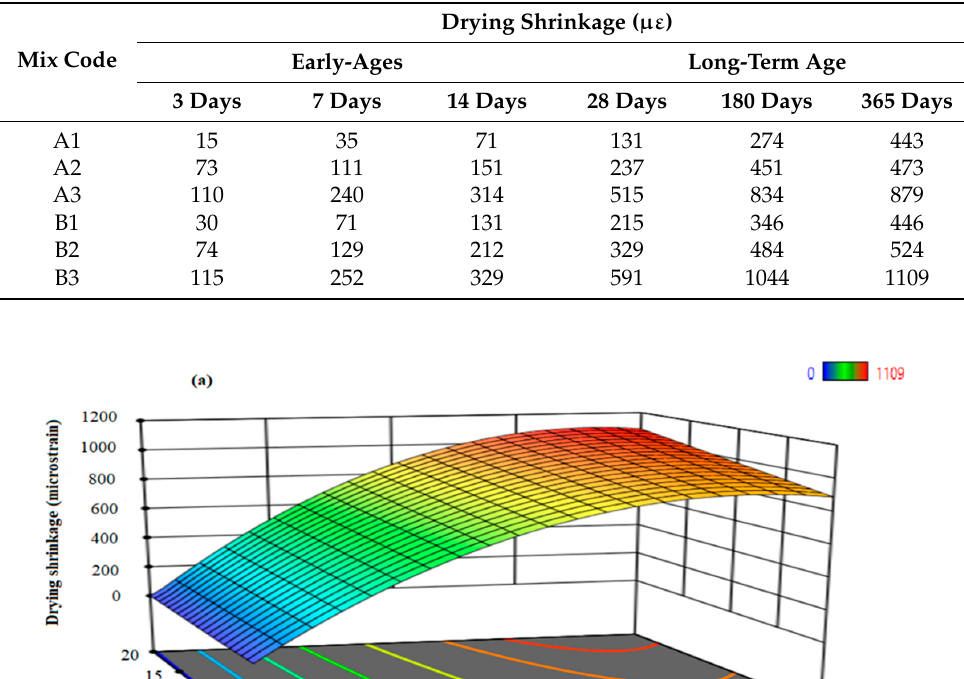
Table 7. Drying shrinkage results under 28 days continuous moist curing.